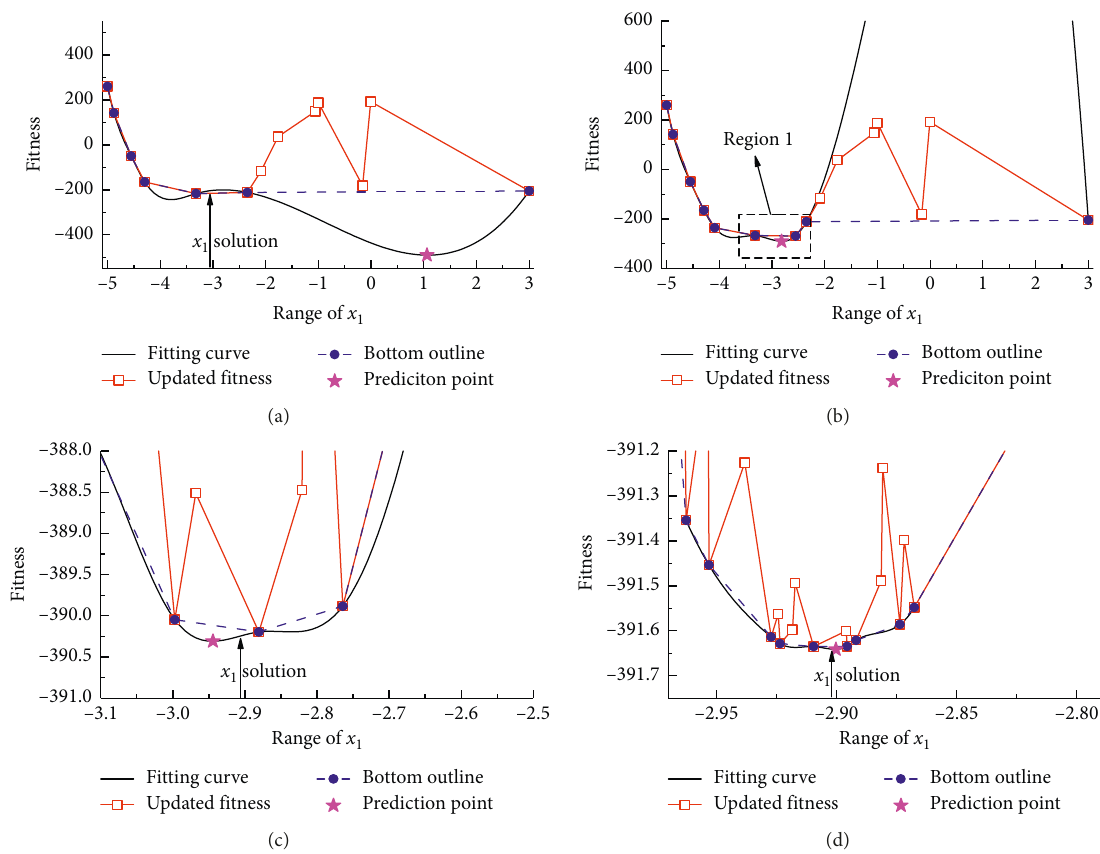
Figure 2: The fitting and prediction curves of some iterative steps in the optimization process of the polynomial accumulation function. (a) 7th iteration. (b) 8th iteration. (c) 16th iteration (enlarged). (d) 25th iteration (enlarged). (The updated fitness values are obtained by calculation. The bottom outline of the updated fitness values is acquired by data processing, and their smallest 9 points are used to form a fitting curve with the spline method. Then, a prediction point is determined).